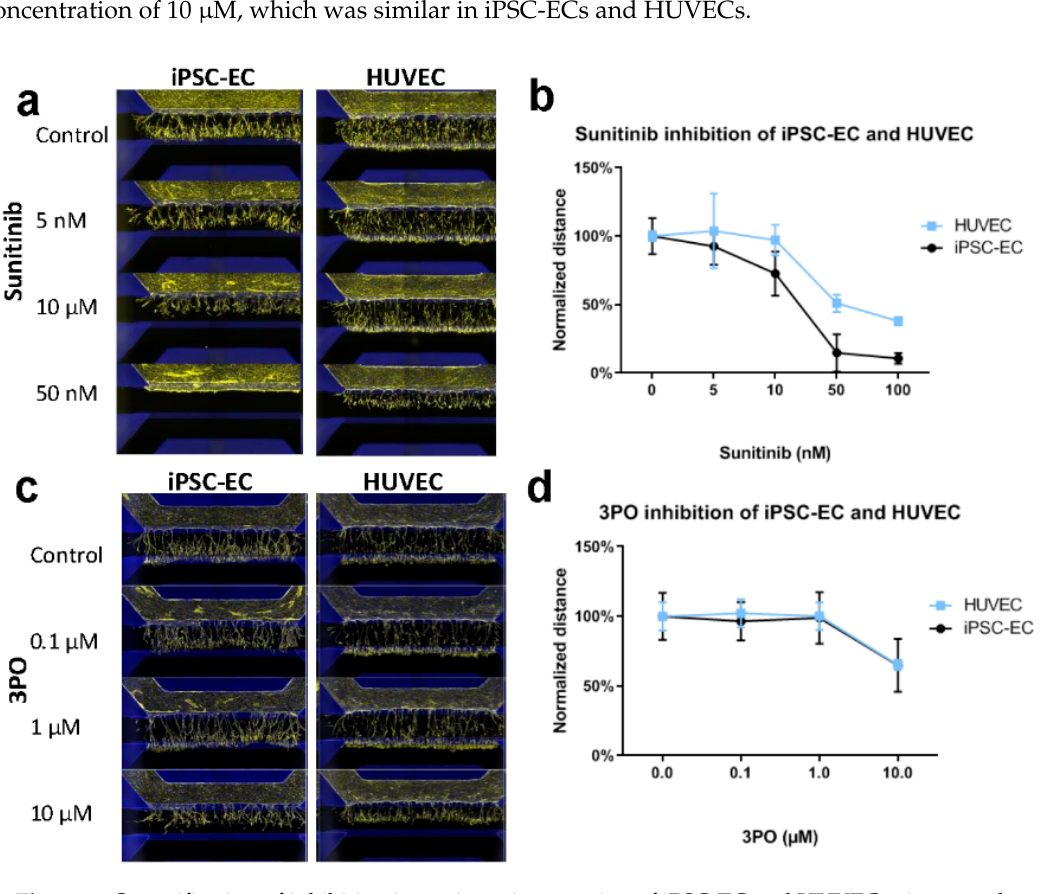
Figure 3. Quantification of inhibition in angiogenic sprouting of iPSC-EC and HUVEC microvessels. ( a , b ) Sunitinib inhibited angiogenic sprouting of both iPSC-EC and HUVEC microvessels. While sprouting of iPSC-ECs was completely inhibited at 50 nM, HUVECs still showed limited migration and sprout formation ( N = 2). ( c , d ) Inhibition with 3PO shows a significant reduction in sprouting at 10 µM of both IPSC-EC and HUVEC microvessels ( N = 2).